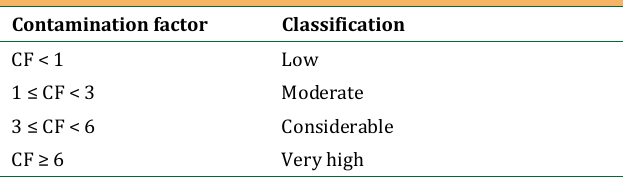
Table 4: Classification of contamination factor